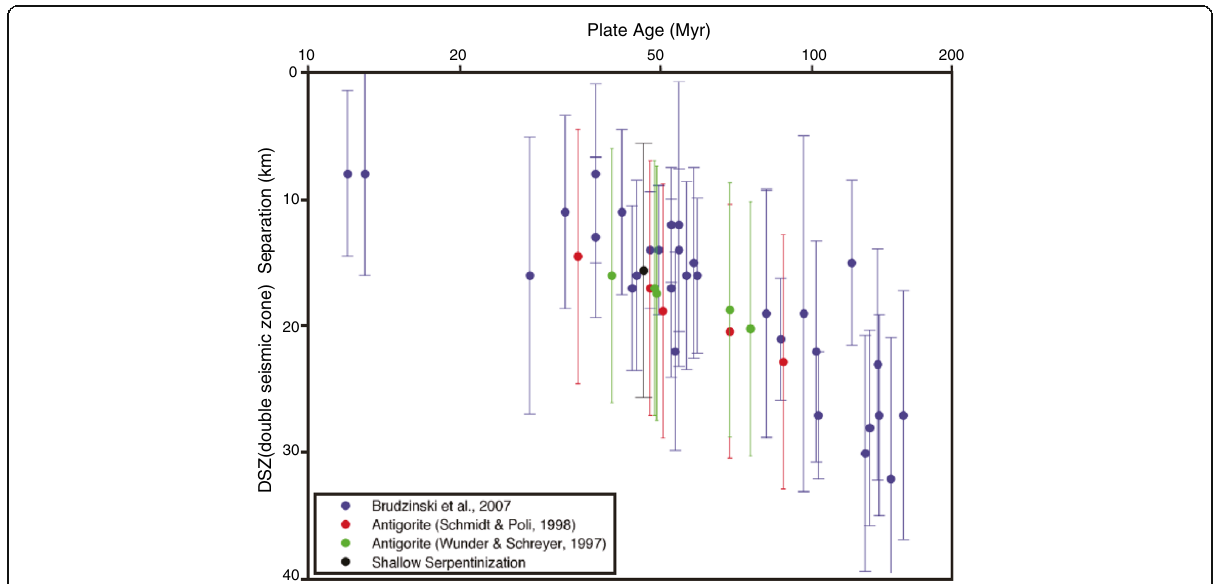
Fig. 23 Separation of the double seismic zone plotted against plate age. The separation of the double seismic zone obtained from a dynamic thermomechanical – petrological model is plotted against the age of the subducting slab. The distances from the middle of the oceanic crust to the level where fluids concentrate are shown by red and green dots. Vertical lines show error bars. Red and green dots are based on models of antigorite dehydration by Wunder and Schreyer (1997) and by Schmidt and Poli (1998), respectively. Blue dots are globally observed data reported by Brudzinski et al. (2007). (After Faccenda et al.